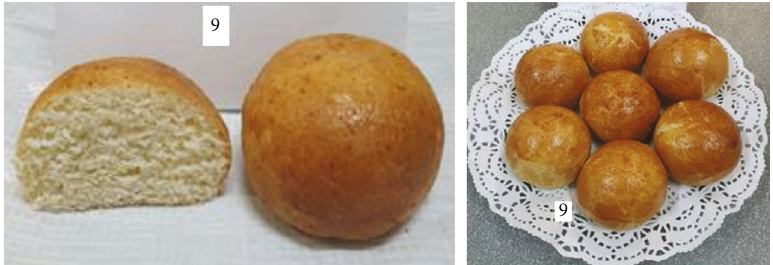
Figure 10: Sample no. 9 made from 5% mu ffi n and 10% chickpea fl our with 30 g of sugar beet powder added.